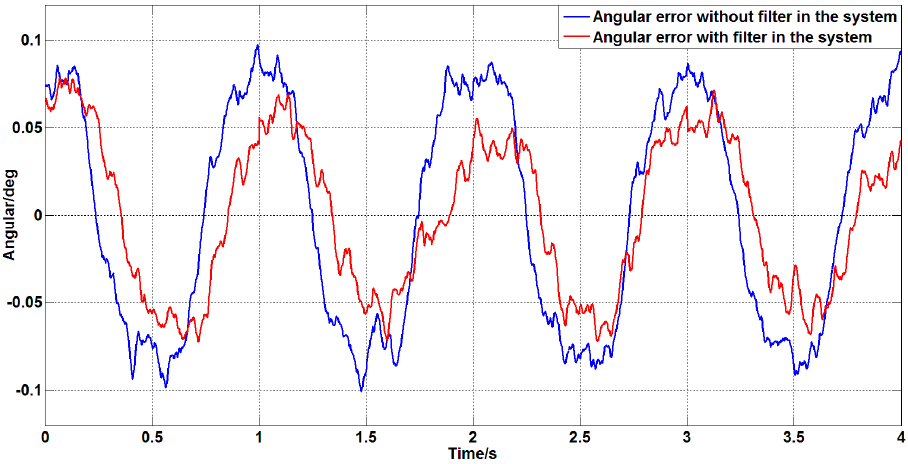
Figure 28. The angular error of the system with or without a filter under disturbance.